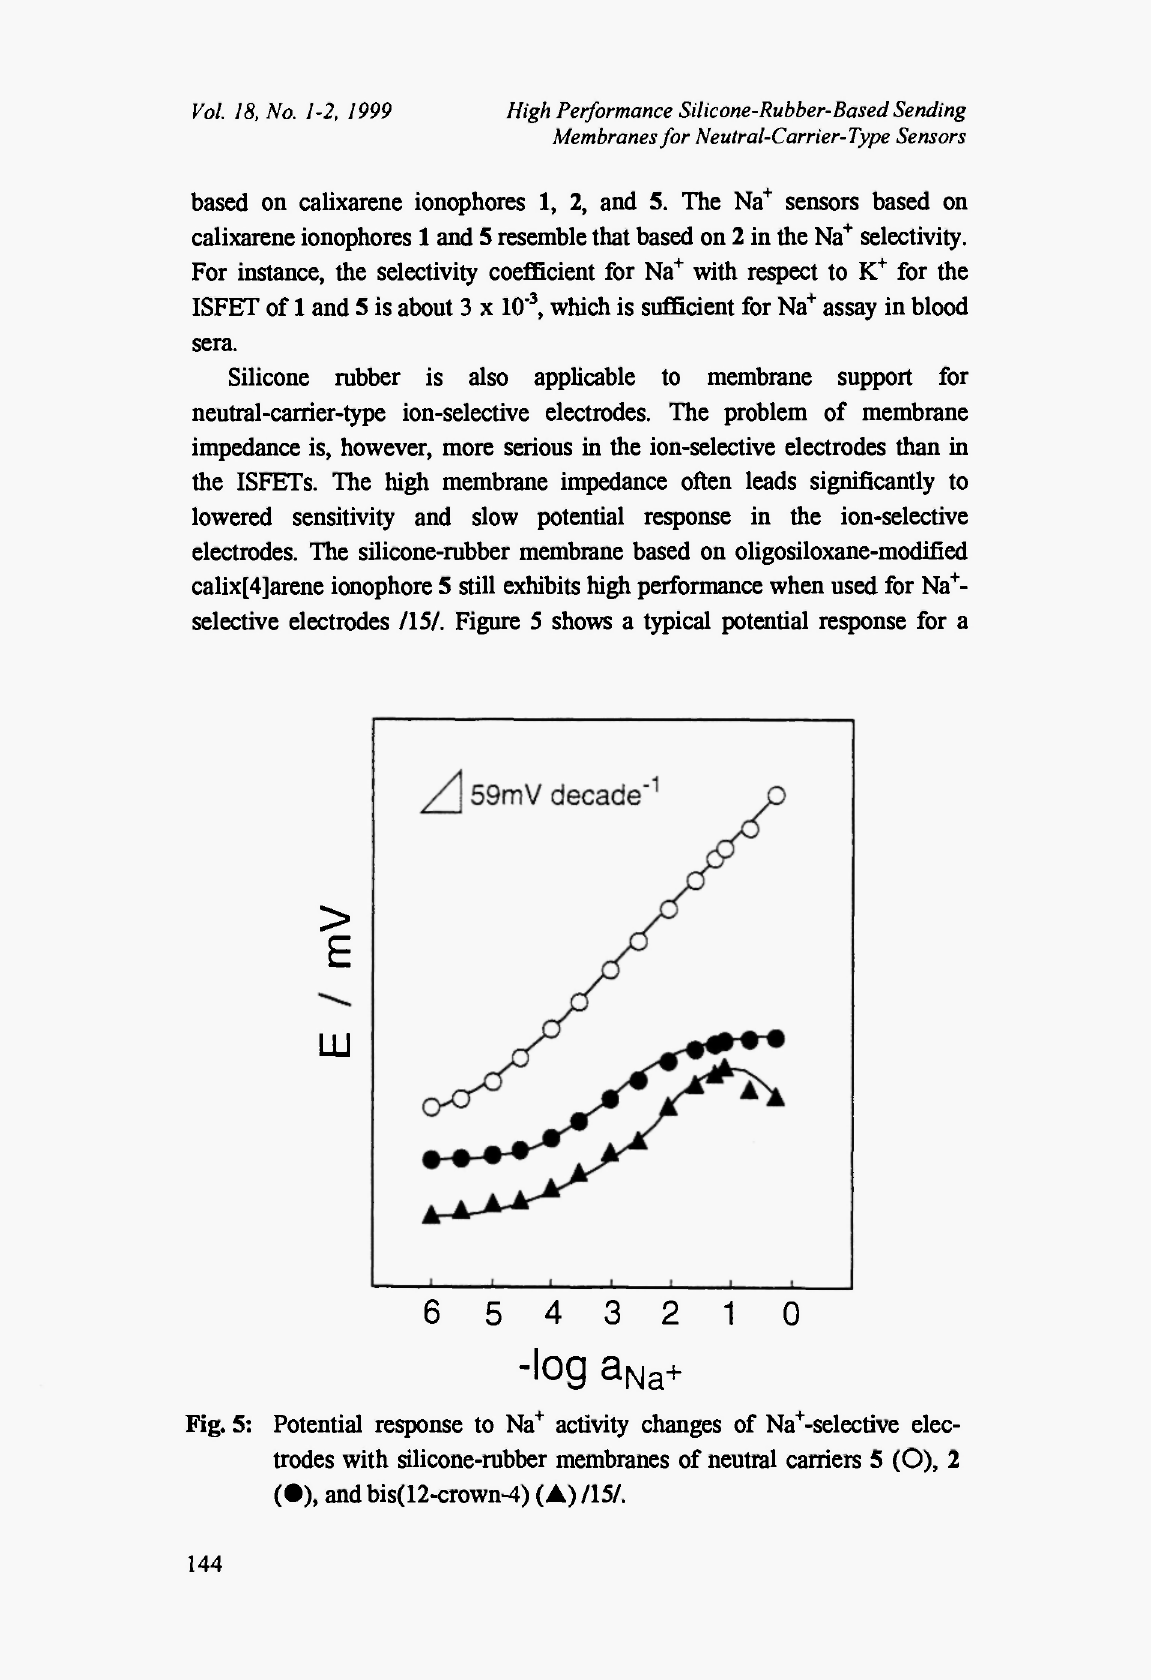
Fig. 5: Potential response to Na + activity changes of Na + -selective elec- trodes with silicone-rubber membranes of neutral carriers 5 (O), 2 ( · ), and bis(12-crown-4) (A)